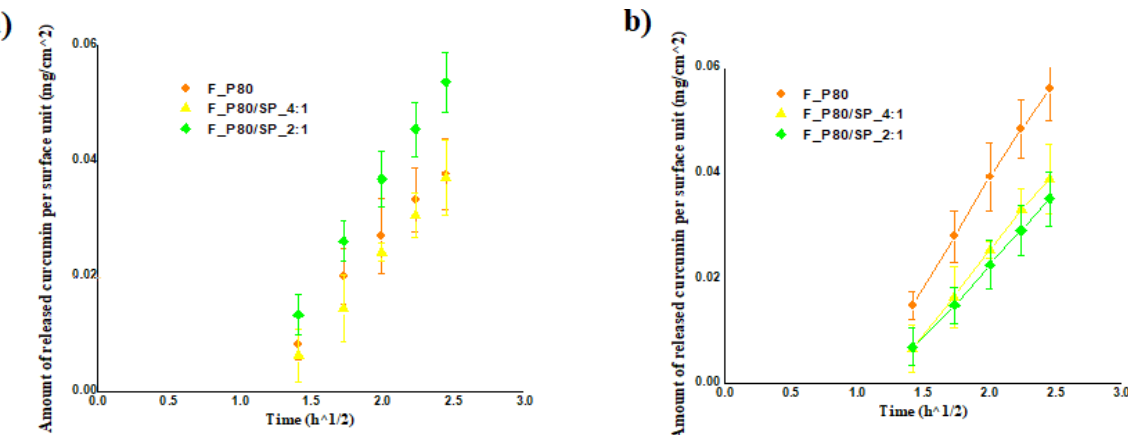
Figure 6: In vitro dissolution/release kinetics of the thickened curcumin nanocrystal dispersions (a) and curcumin coarse dispersions (b)